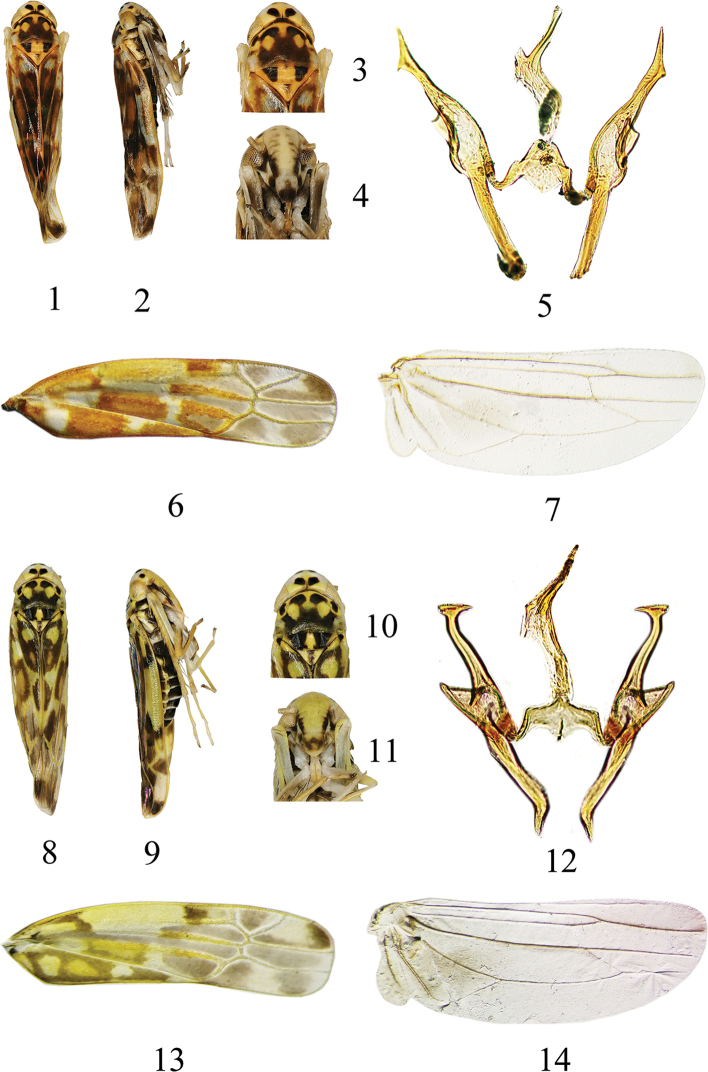
Species of Mitjaevia1–7Mitjaevia
shibingensis sp. nov. 1 habitus, dorsal view 2 habitus, lateral view 3 head and thorax, dorsal view 4 face 5 style and connective, ventral view, aedeagus lateral view 6 forewing 7 hindwing 8–14Mitjaevia
dworakowskae sp. nov. 8 habitus, dorsal view 9 habitus, lateral view 10 head and thorax, dorsal view 11 face 12 style and connective, ventral view, aedeagus lateral view 13 forewing 14 hindwing.